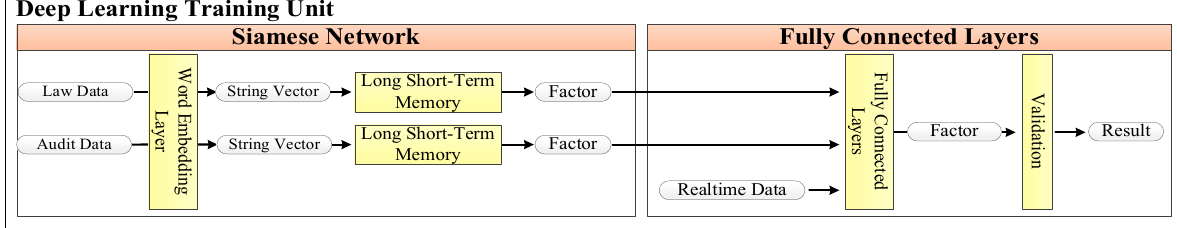
Figure 9. The flowchart of the deep learning training unit.